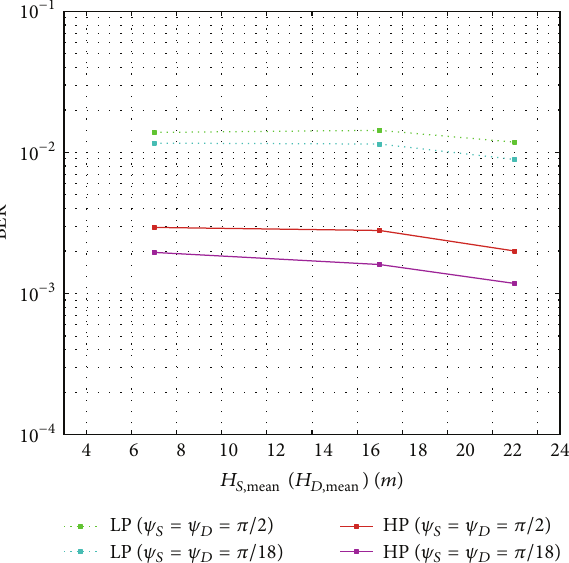
Figure 10: BER for increasing values of the mean height of the scatterers within cylinders 1 and